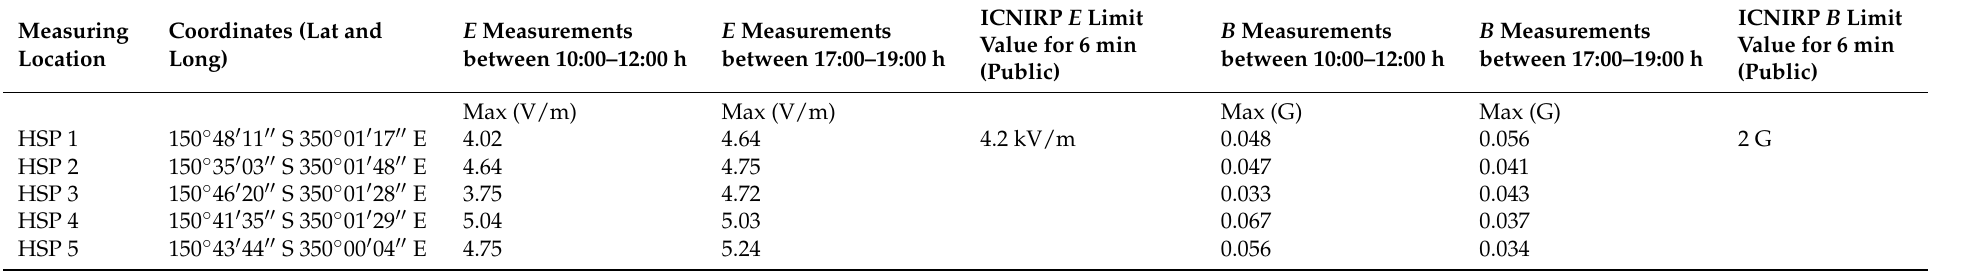
Table 5. Statistical results of E and B in hospitals.